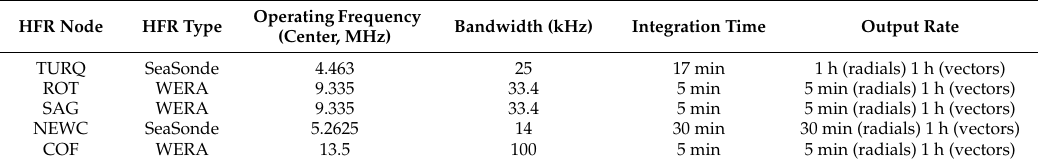
Table 1. Operational settings for the High-Frequency Radar (HFR) systems across Australia; locations of the HFR systems for the Western Australia (WA) node are given in Figure